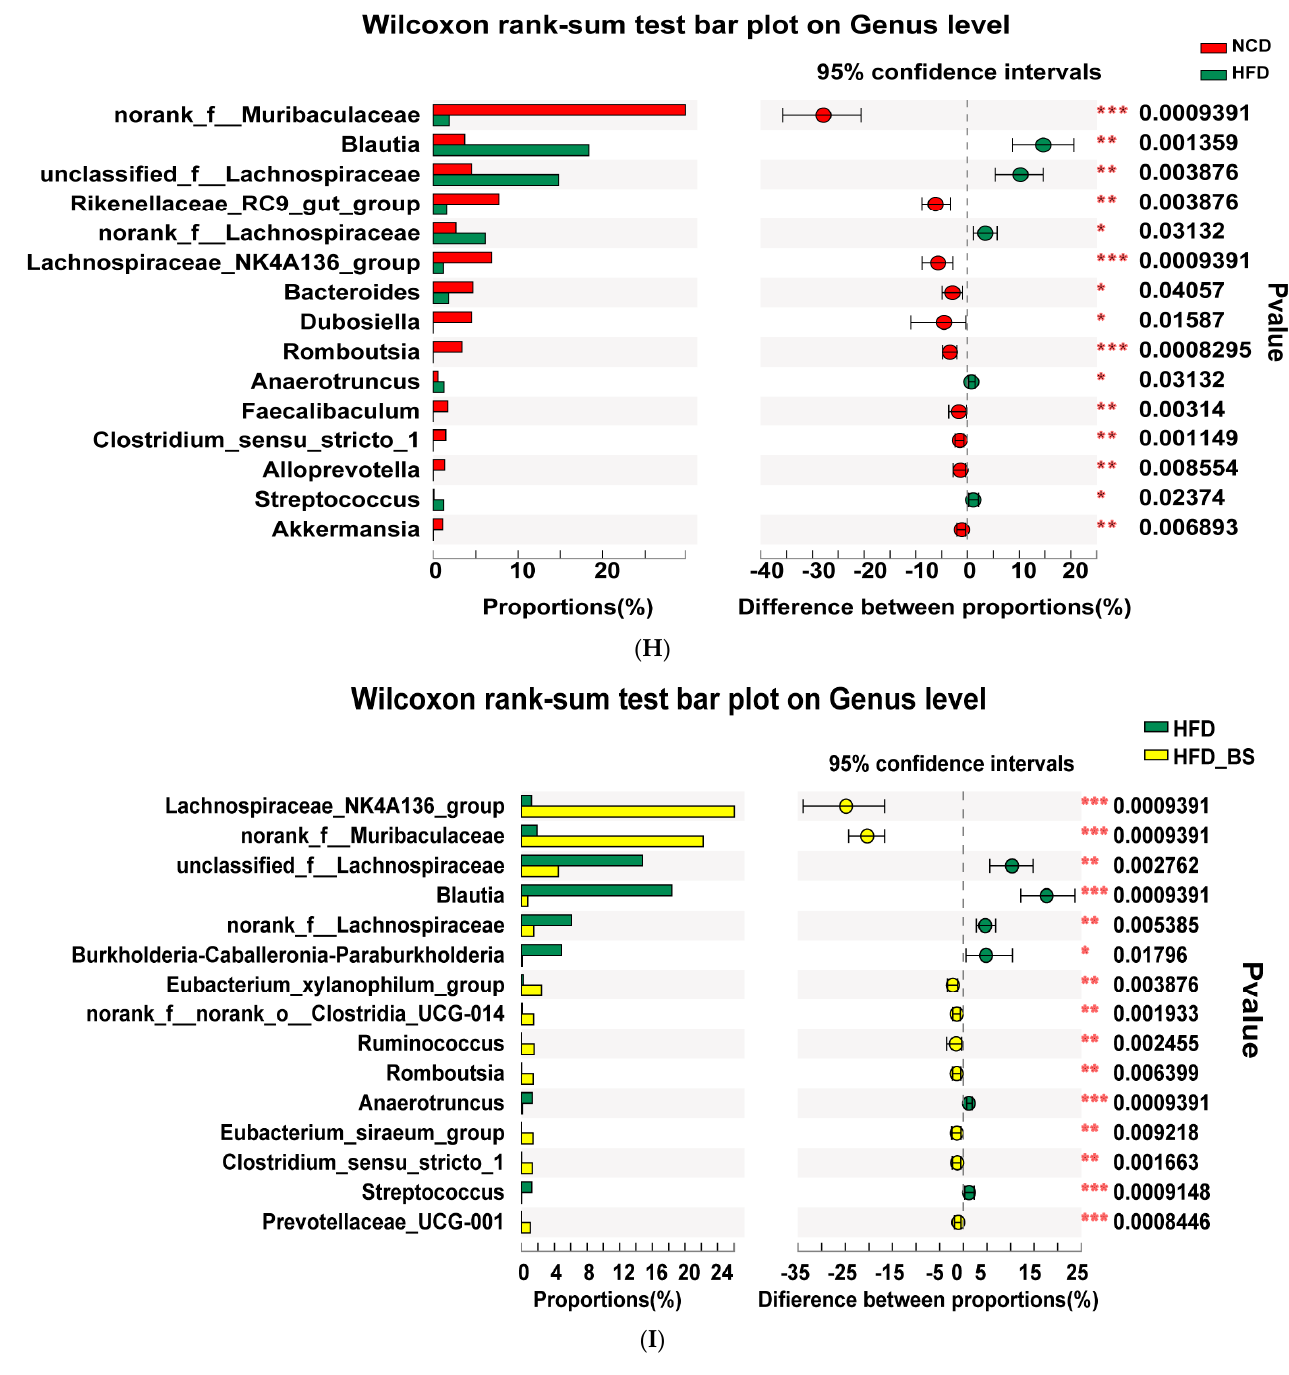
Figure 4. BS attenuated gut microbiota dysbiosis in HFD − fed mice. ( A , B ) Community richness, accessed by the ACE and Chao indices. ( C , D ) Community diversity, accessed by the Heip and Shannoneven indices. Means denoted by a different letter (a, b, c, d) indicate significant differences between groups ( p < 0.05). ( E , F ) PCoA and NMDS score plots based on Bray − Curtis. ( G ) The abundances of gut microbiota at the phylum level. ( H , I ) Mean proportions of key genera in different groups at the genus level based on the Wilcoxon rank-sum test. * p < 0.05, ** p < 0.01, *** p < 0.001 (in H , I ). n = 8 per group. NCD, normal control diet; NCD − BS, normal control diet supplemented with freeze − dried powder of bamboo shoots; HFD, high − fat diet; HFD − BS, high-fat diet supplemented with freeze-dried powder of bamboo